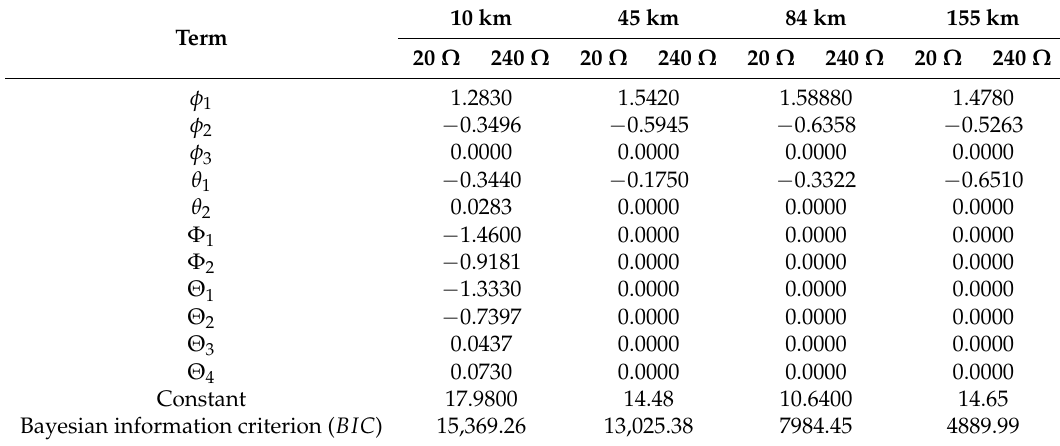
Table 3. Some examples of models obtained.